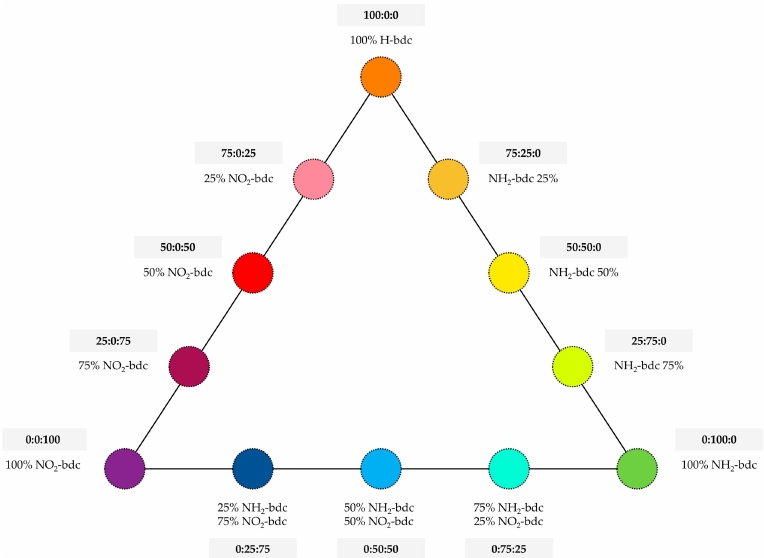
UiO-66-based metal–organic frameworks (MOFs) prepared with di ff erent contents of functional groups, labeled in the triangular diagram as percentages of functionalized terephthalate